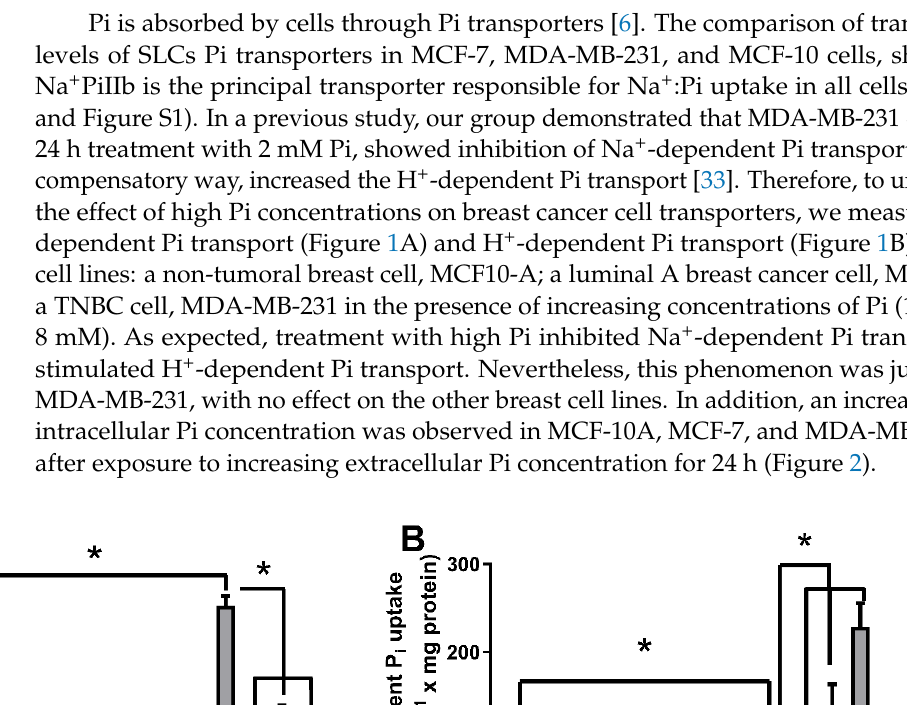
Figure 2. Effect of inorganic phosphate concentrations on total intracellular Pi in breast cell lines. Different breast cell lines: MCF10-A (blank bars) ( A ), MCF-7 (grey bars) ( B ), and MDA-MB-231 (dark grey bars) ( C ) were treated with various Pi concentrations (1, 2, 4 or 8 mM Pi) for 24 h and total intracellular Pi concentrations were determined, as described in Section 4. Bars represent mean ± SE of at least three independent biological samples. * p < 0.05 indicates changes were significantly different, as assessed by ANOVA followed by Tukey’s multiple comparison test. In this work, we used 1 mM Pi to represent the serum Pi concentration in healthy patients, and 2 mM and 4 mM Pi for serum Pi concentrations in cancer patients [8]. Seek- ing to understand how this effect occurs, we observed that 8 mM Pi was the concentration where we obtained the most pronounced regulatory effect. For a better analysis, in some experimental tests, we used the concentration 8 mM Pi as high Pi and 1 mM Pi as control.